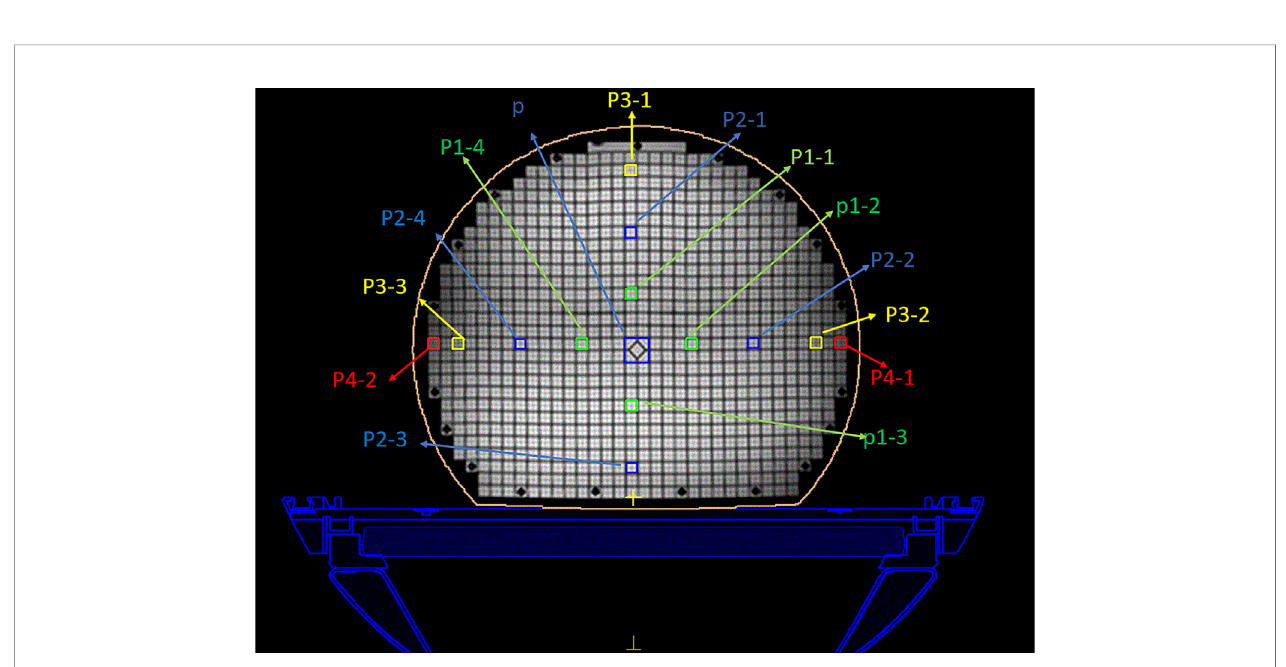
FIGURE 3 | Regions of interest of the MRI image. The center diamond square is regarded as the central point. The green, blue, and yellow circle represent the 5 cm, 10 cm, and 15 cm ranges,